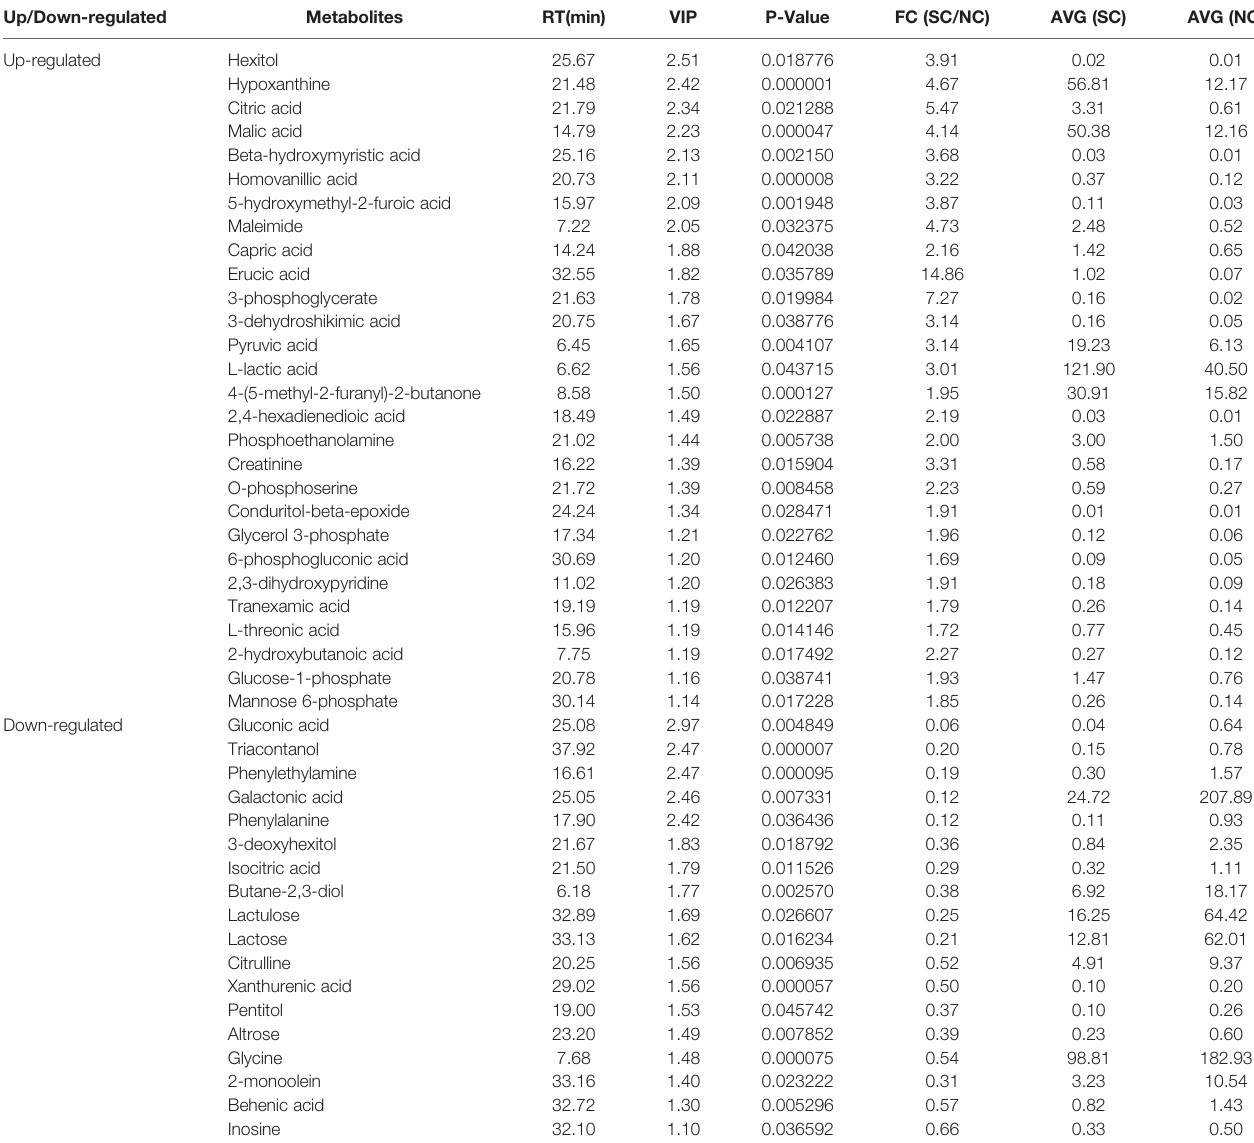
TABLE 4 | Signi fi cantly differential metabolites in gills of SCvsNC group. Up/Down-regulated Metabolites